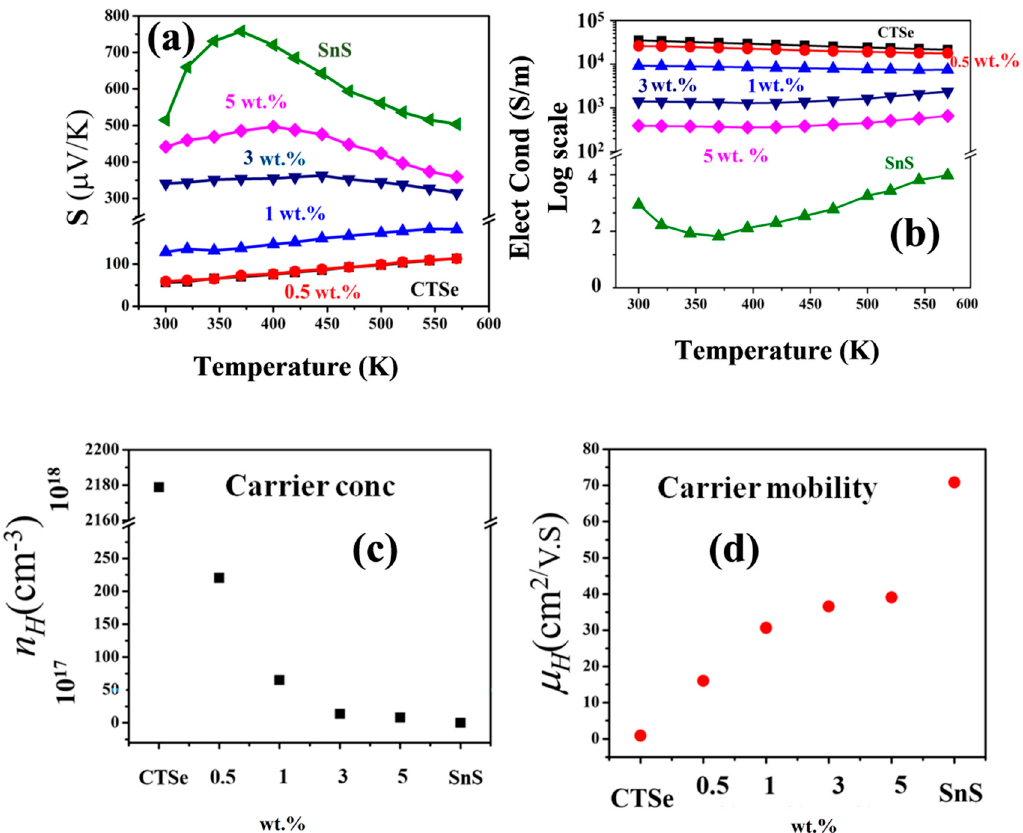
Figure 6. Temperature dependence of ( a ) the Seebeck coefficient, ( b ) electrical conductivity, ( c ) carrier concentration, and ( d ) electronic mobility values of the CTSe, SnS, and CTSe-SnS composites. Each data point of ( c ) and ( d ) is the average of ten readings recorded on each sample. Table 2. Hall-E ff ect data of the spark plasma sintered Cu 2 SnSe 3 , SnS, and Cu 2 SnSe 3 -SnS composites.